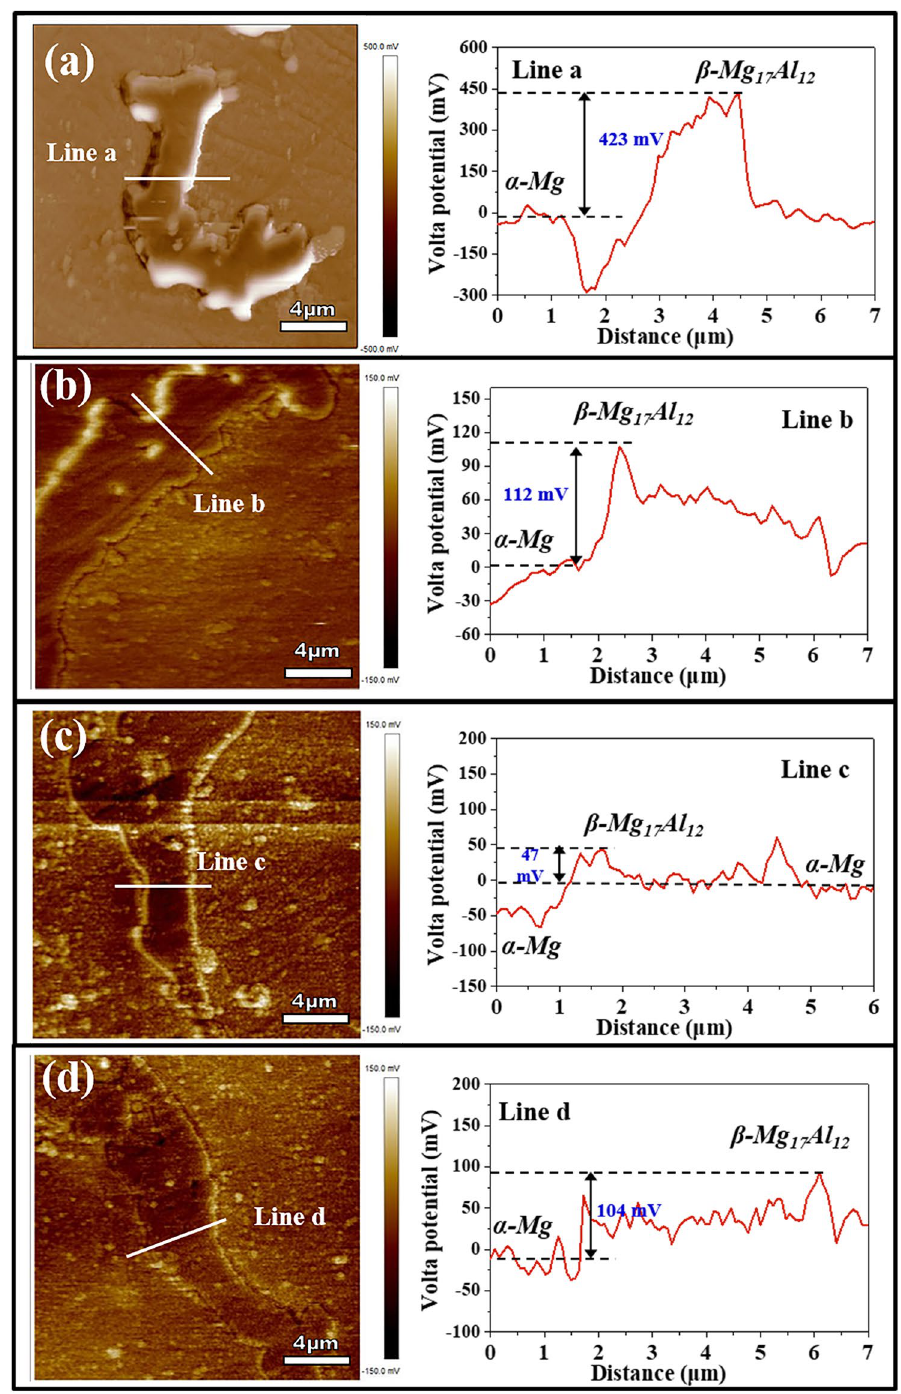
Figure 8. The surface volta potential maps of AZ91 alloys and corresponding potential profile of marked line after immersing in 3.5 wt% NaCl solution ( a ) without and with addition of ( b ) 2 g/L GUE ( c ) 2 g/L PDE ( d ) 2 g/L TOE for 24 h under normal atmospheric